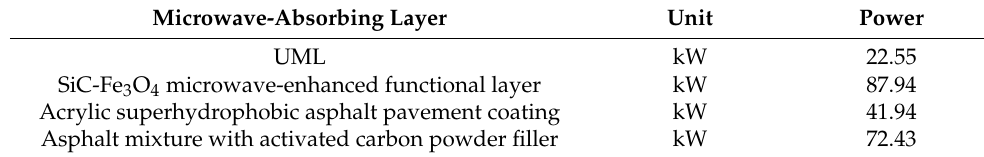
Table 7. Power required for different microwave-absorbing